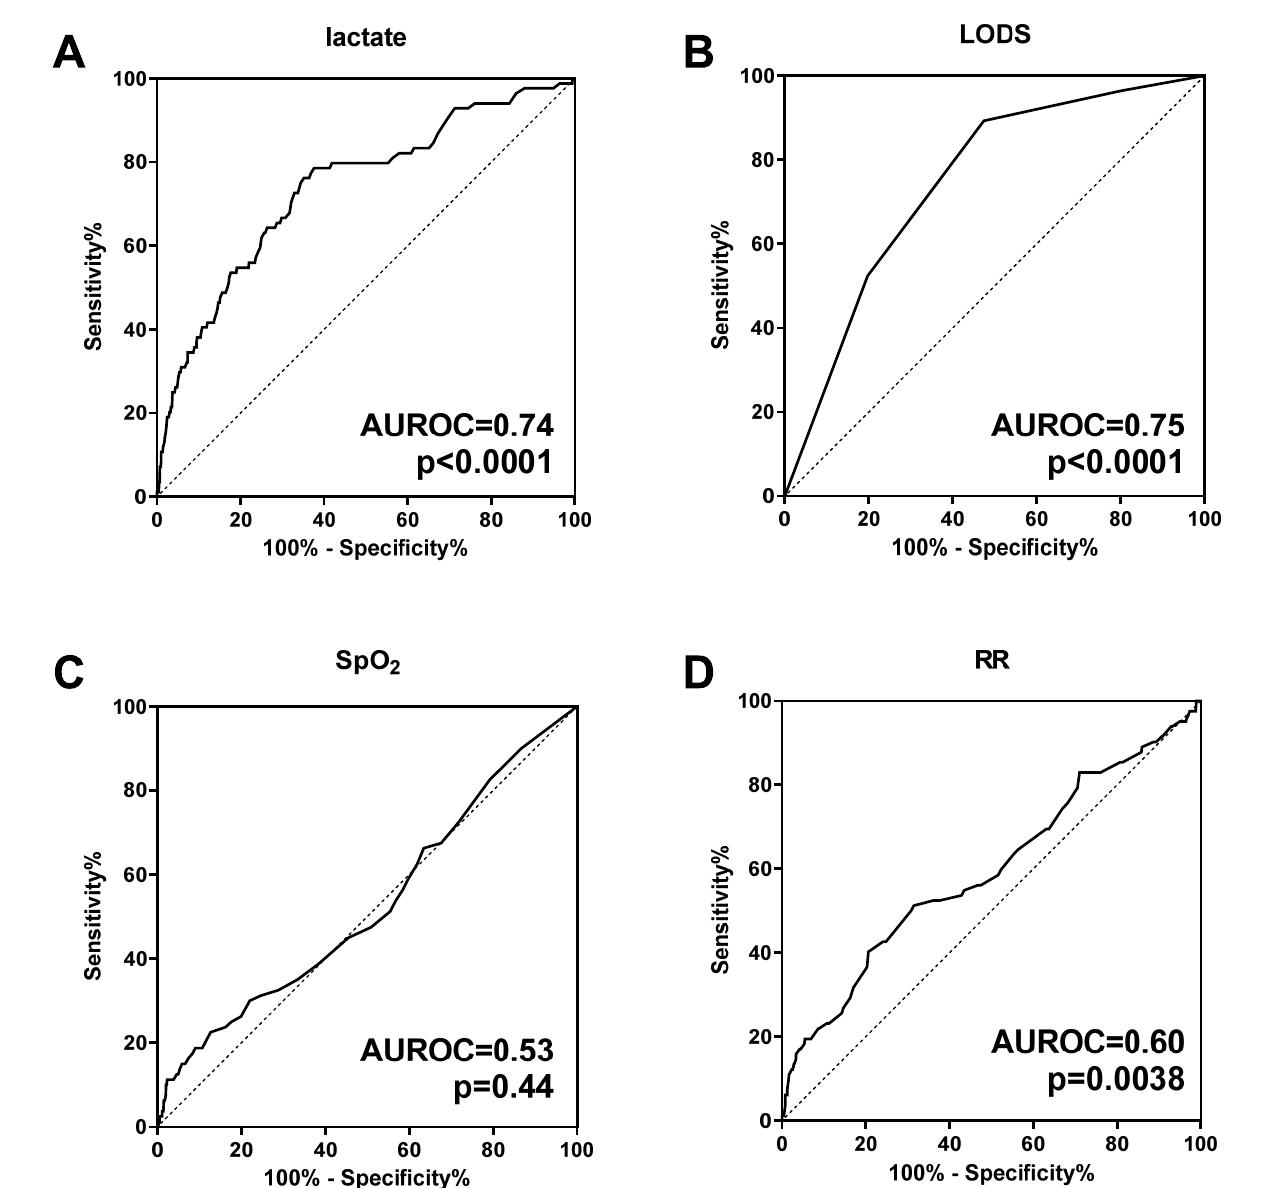
Figure 2. Lactate measurements at admission discriminate fatal from nonfatal malaria with respiratory distress. Receiver operator characteristic (ROC) curves were generated for ( A ) blood lactate concentration at admission, ( B ) Lambaréné Organ Dysfunction Score (LODS), ( C ) oxygen saturation (SpO 2 ), and ( D ) respiratory rate (RR). Area under ROC (AUROC) and p -values are provided for each curve. There was no statistically significant difference between the AUROC for blood lactate versus LODS (AUROC 0.74 vs. 0.75, p = 0.80).